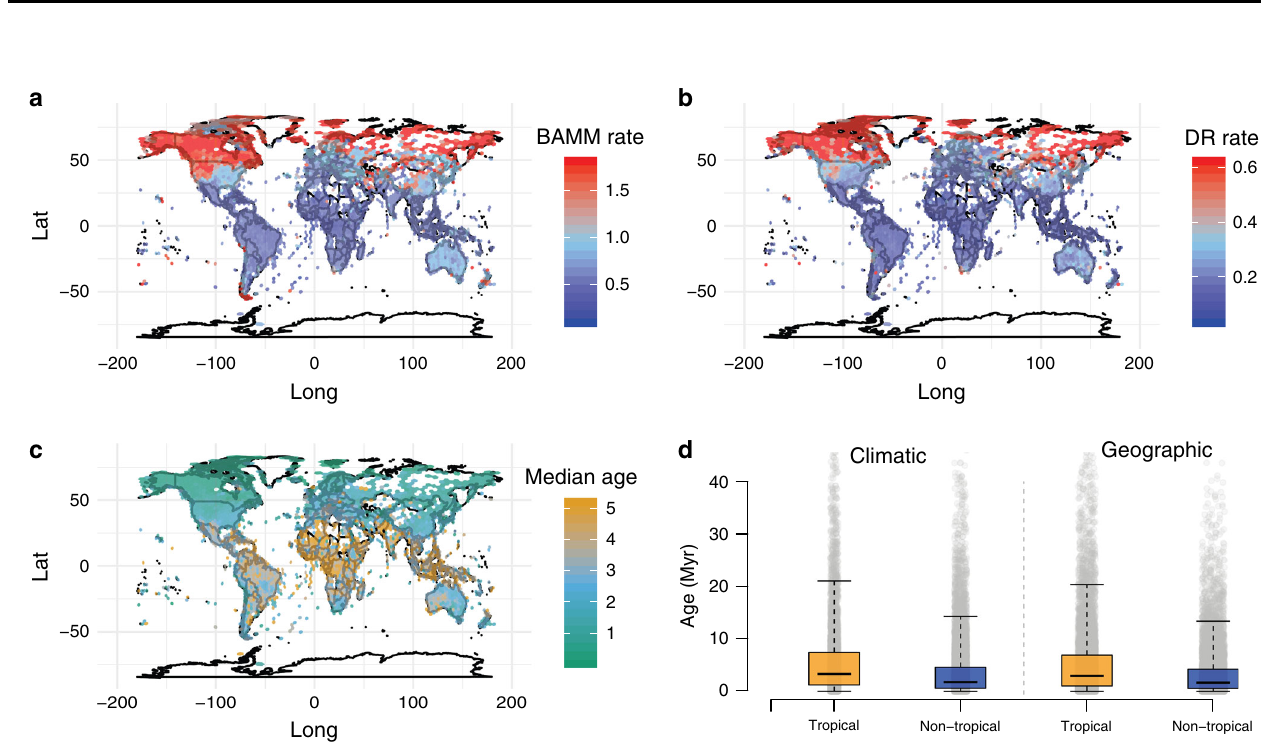
Fig. 2 Global distribution patterns of median tip rates and median species age. Tip rates estimated by BAMM ( a ) and DR ( b ) (red = faster, and blue = slower); species tip age ( c ) is de fi ned as the age of the parent node for any given tip and reported as the grid cell median (orange = older; green = younger); d boxplot of median species age for tropical (orange) and non-tropical (blue) species under both climatic and geographic de fi nitions. t -test: both two-tailed; climatic p = 3.5518e − 68 and geographic p = 2.3176e − 82; median — solid line in the box, box — interquartile range [25% and 75%], whiskers — 5% and 95% intervals; n = 6160, 11,475, 8870, and 9399, respectively; see gray dots for data distribution. All values in a – c are plotted in equal-area grid cells (~322 km 2 ); source data are provided in Source Data fi